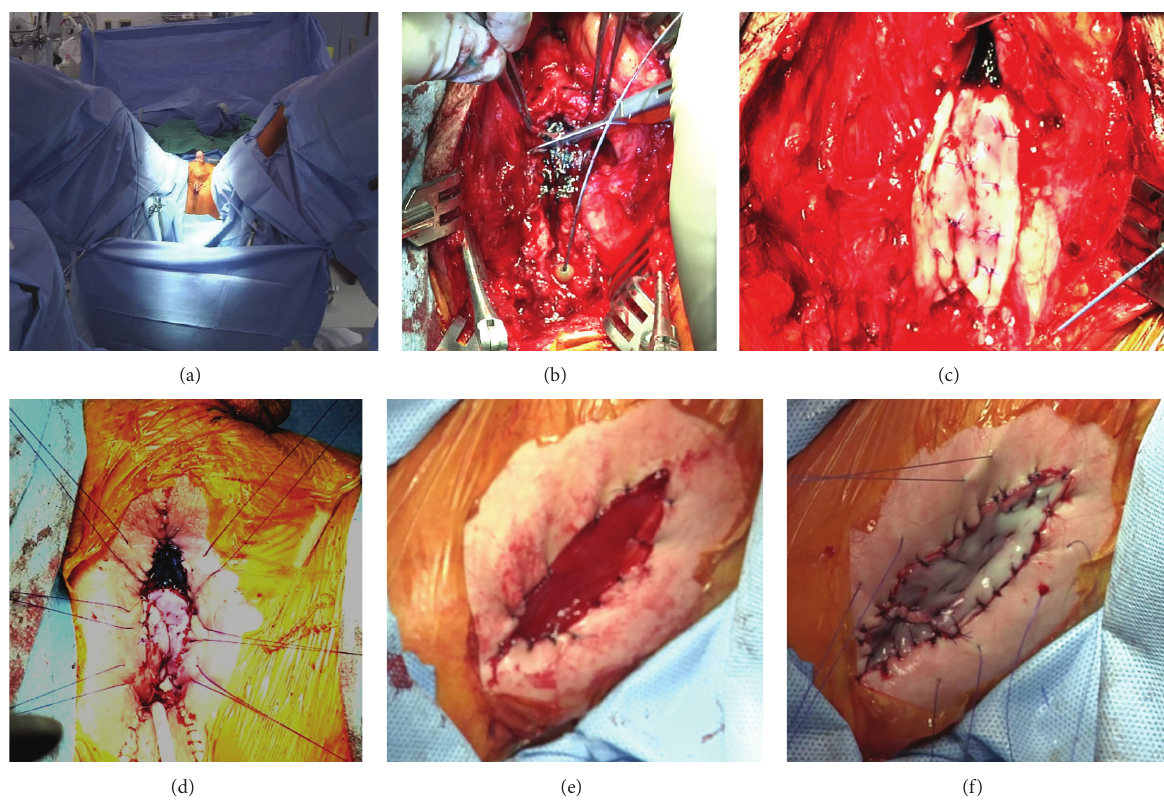
Figure 2: Steps of the Stage 1 procedure. (a) Patient positioned with access to the perineum and the left inner thigh, (b) transection of the affected urethral plate, (c) dorsal plate augmented with buccal mucosa, (d) augmented perineal urethrostomy with catheter in place (preparation for the tie-over dressing), (e) exposed distal gracilis, and (f) buccal mucosa quilted on the gracilis.